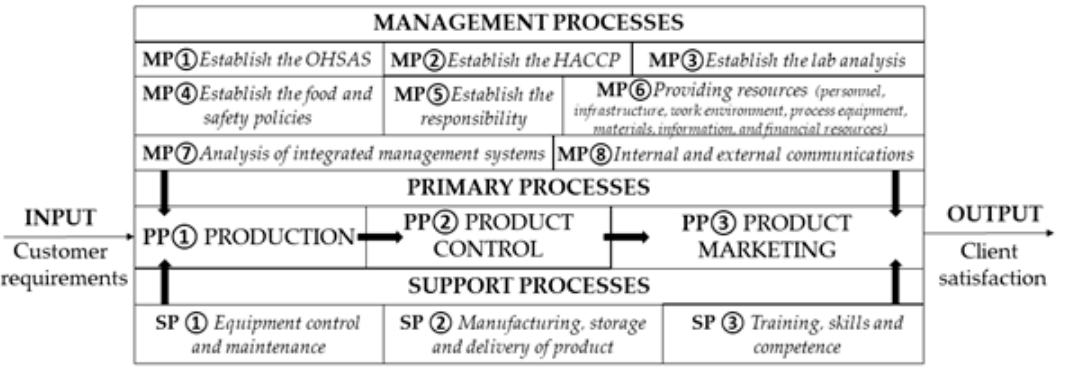
Figure 3. Process map for the integration between food safety and OHS safety in an Integrated Management System.